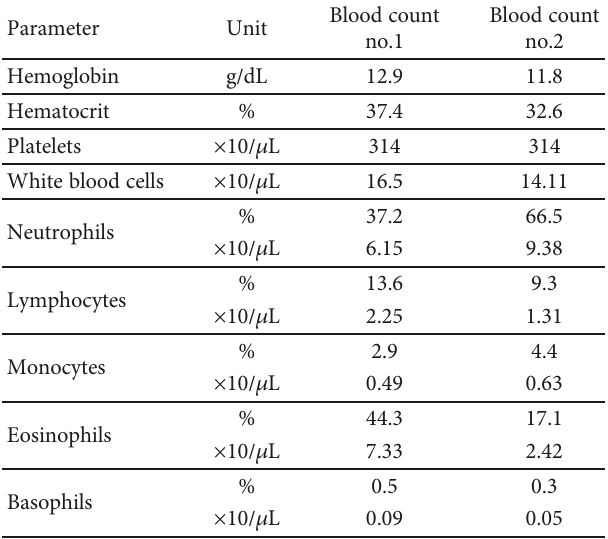
Table 1: Blood count no. 1 is correlated with testicular artery occlusion. Blood count no. 2 is correlated with appendicitis. Both disease patterns are secondary to infection by A. costaricensis.